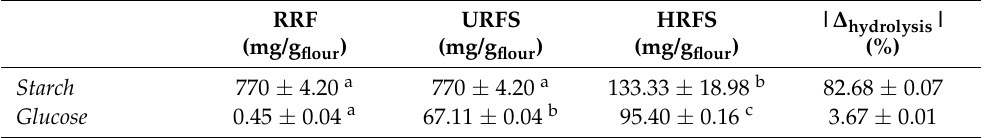
Table 1. Starch and glucose content in raw rice flour (RRF), un-pretreated rice flour suspension (URFS), and hydrolyzed rice flour suspension (HRFS); ∆ hydrolysis of starch and glucose resulting from the enzymatic treatment as percent variation and evaluated with respect to the initial starch amount. The values marked with different lowercase letters in the same arrow are significantly different ( p <